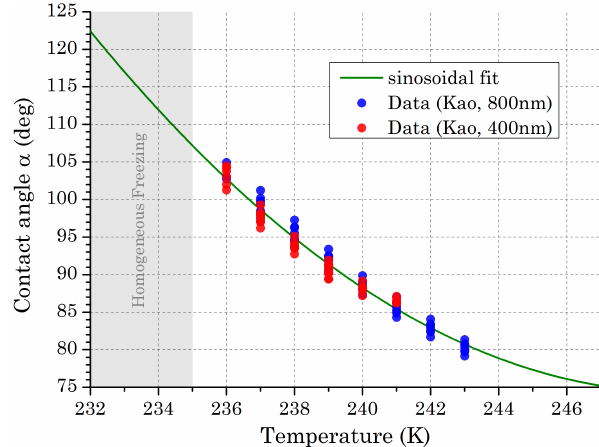
Fig. 9. Contact angle vs. temperature for 400nm and 800nm kaoli- nite particles in the immersion mode. Calculated using classical nu- cleation